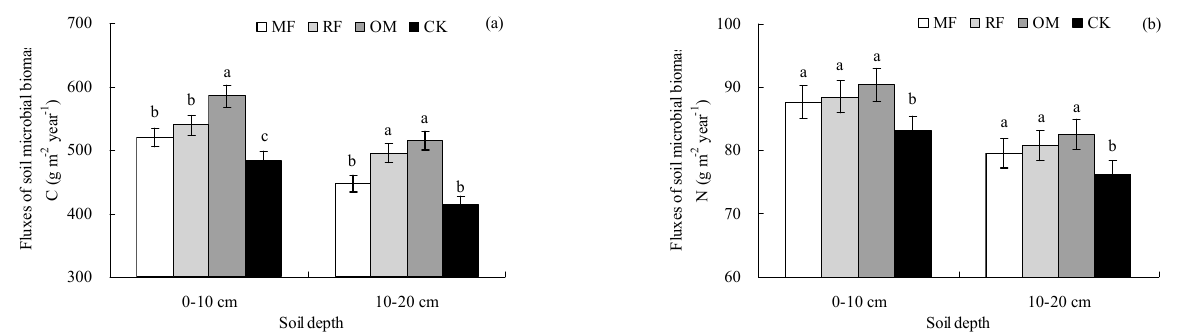
Figure 2. Effects of different long-term fertilizer treatments on the flux of soil microbial biomass carbon ( a ) and nitrogen ( b ) in the double-cropping rice field. Different lowercase letters indicate significant differences ( p < 0.05) among different fertilizer treatments.